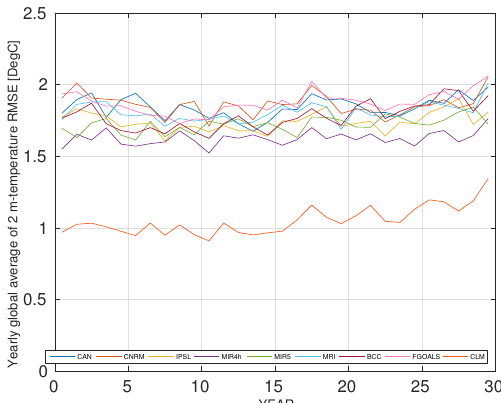
Figure 2. Temporal evolution of the global and annual average of the 2m temperature RMSE for the eight climate models (after bias correction) and the climatology. During the 30 years of the simula- tions, the skill of most of the models did not decline. In fact, a sim- ple linear fit to the models indicates that some of them increased their skill with